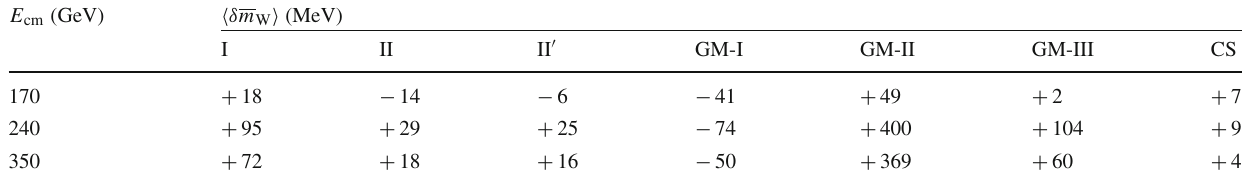
Table5.1 ReconstructedaverageWmassshiftpredictedbydifferentCRmodelsin Pythia 8,relativetotheno-CRbaseline,ine + e − → W + W −